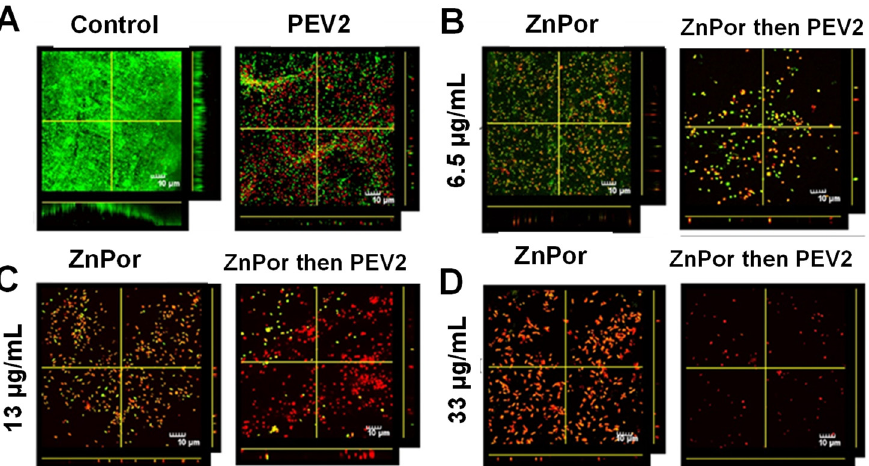
Figure 5. Biofilms of PAO1 treated with ZnPor or PEV2 alone, and in combination in the absence of photoactivation. Biofilms of strain PAO1 were grown on coupons cut from polyethylene in a CDC-approved bioreactor. The biofilms were then exposed to ( A ) PBS (control) or PEV2 (MOI 10:1), or ZnPor and ZnPor/PEV2 exposure at ZnPor concentrations of ( B ) 6.5 µ g/mL, ( C ) 13 µ g/mL, or ( D ) 33 µ g/mL. For joint ZnPor/PEV2 experiments, biofilms were pre-treated with ZnPor for 2 h followed by the addition of phage PEV2 (MOI 10:1) and incubated for 4 h. Biofilms were stained with LIVE/DEAD TM fluorescent stain and imaged using confocal laser scanning electron microscopy (CLSM) at 60 × . Green = LIVE, red = DEAD. Control refers to a biofilm that received no